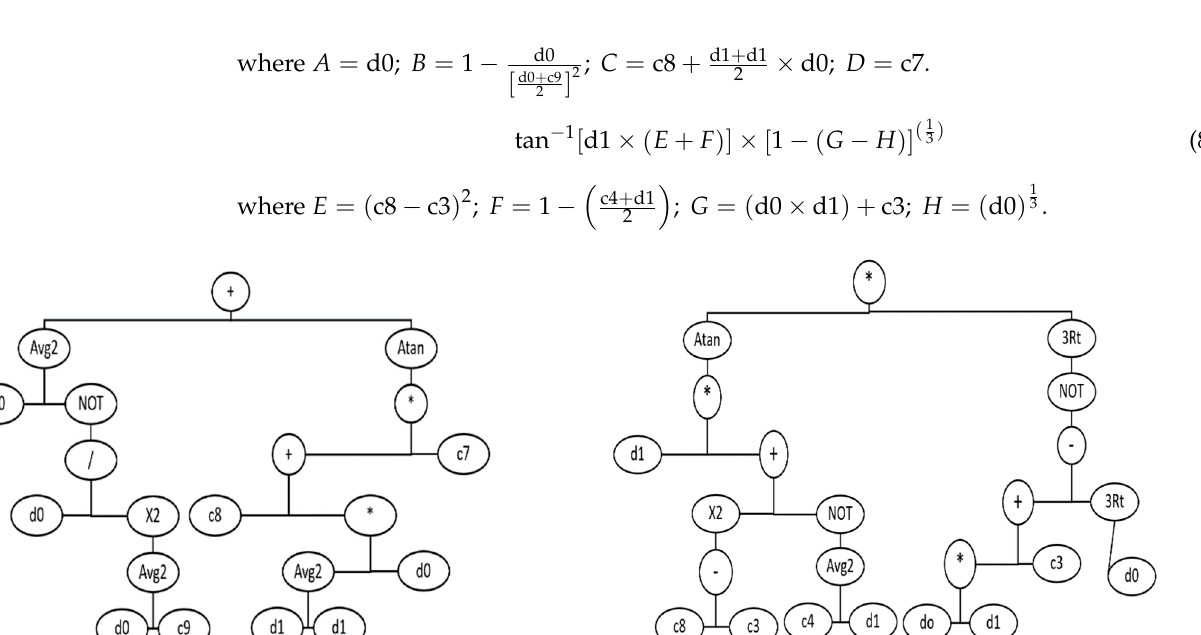
Figure 6. Sub ET-7 ( left ) and Sub ET-9 ( right ) of selected model.